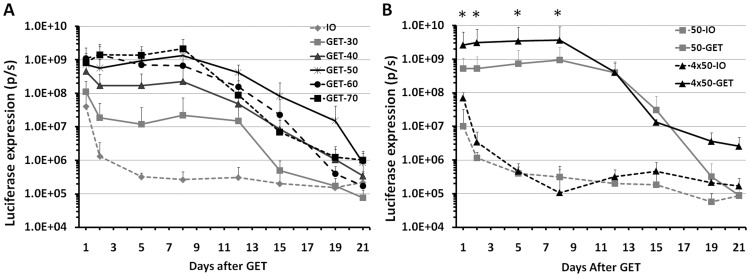
Kinetic of gene expression in HLGP skin after intradermal DNA injection and non-invasive GET.
A, Time course of luciferase expression in HLGP skin after delivery by different electric fields at day 0. 50 µL DNA and 1 pulse delivery for all delivery groups, IO: no pulse delivery; GET: applied voltage of 30, 40, 50, 60 or 70. *: p<0.05 for GET-50, GET-60 or GET-70 vs IO. B, Time course of luciferase expression in HLGP skin after delivery to different sizes of skin. Delivery groups, 50-IO: 50 µL DNA without pulse delivery; 50-GET: 50 µL DNA with 1 pulse delivery on the injection site; 50 µLx4-IO: 4 injections with 50 µL DNA without pulse delivery; 50 µLx4-GET: 4 injections with 50 µL DNA and each pulse delivery on the injection site. Bars represent mean ± SD. 4–6 sites were analyzed for each delivery parameter, p/s  =  photons/second. * p<0.05 for 4×50-GET vs 50-GET and 4×50-GET vs 4×50-IO.